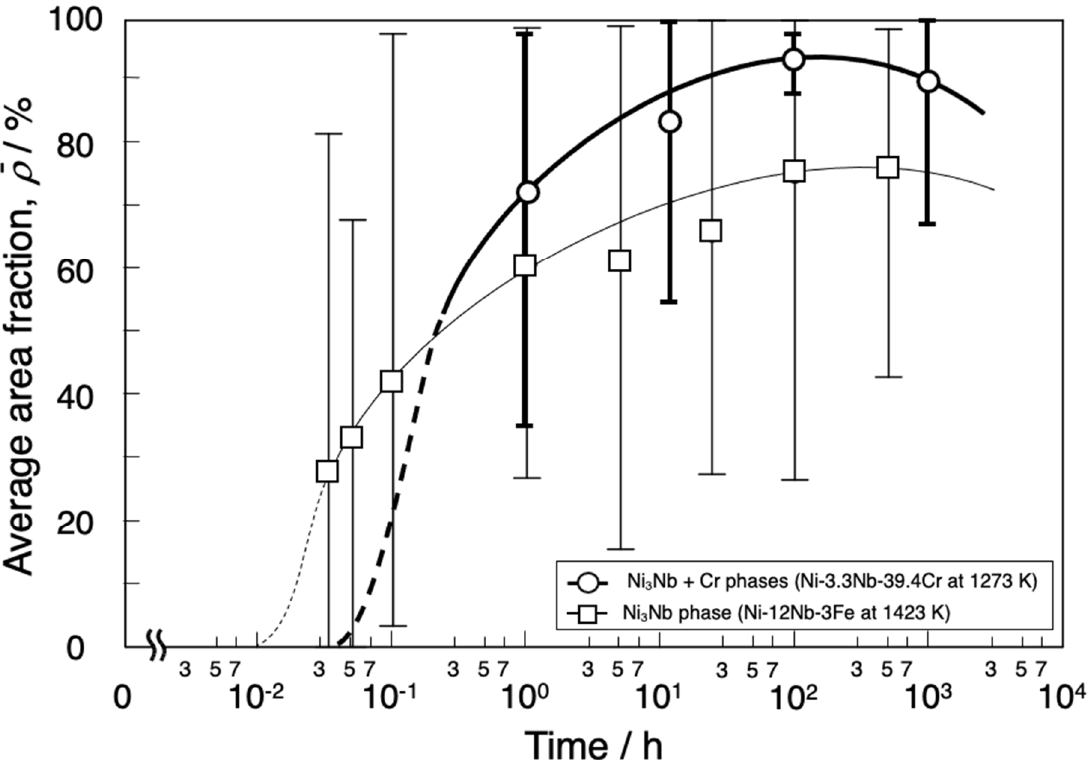
Figure 7. Change in the average area fraction of the Ni 3 Nb phase and the Cr phase on the GB in Ni- 3.3Nb-39.4Cr aged at 1273 K, together with data for the Ni 3 Nb phase in Ni-12Nb-3Fe aged at 1423 K